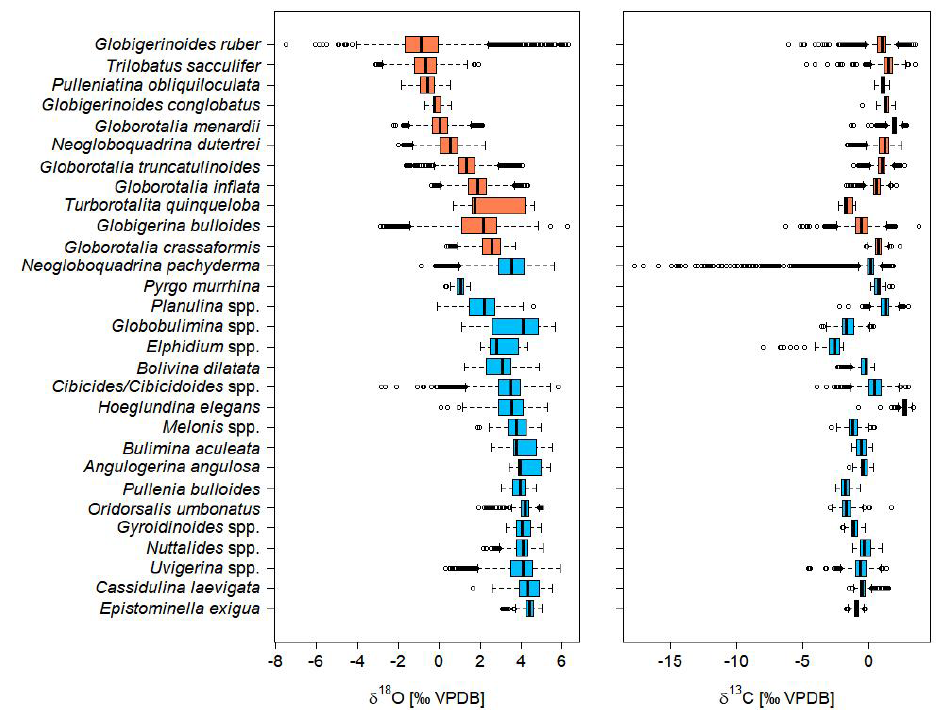
Figure 6. Box-and-whisker plot of oxygen (left) and carbon (right) stable isotope values of planktic (orange) and benthic (blue) Foraminifera at the species or genus level. The vertical line shows the median, left and right margins of the box indicate the 25th and 75th percentiles. The whiskers (the horizontal dashed lines) indicate the maximum/minimum values, or in case of outliers (open circles), highest/lowest data point that is less than 1.5 times above/below the interquartile range. The plot has been created with R’s boxplot() function (R Core Team, 2017).